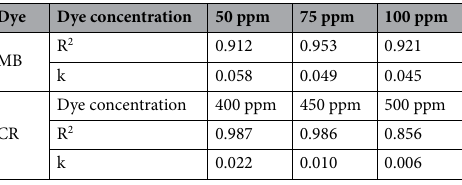
Table 3. Variation in best fit degradation kinetics parameters for MB and CR with initial dye concentration.